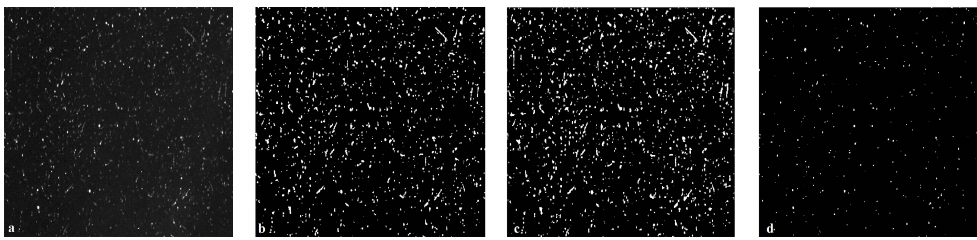
Figure 14. Juno Star Reference Unit’s [45] image segmentation (Credits to NASA): ( a ) real image, ( b ) LTA’s prediction; ( c ) LTS’ prediction; ( d ) the BOSS algorithm’s prediction. Considering the processing of these three